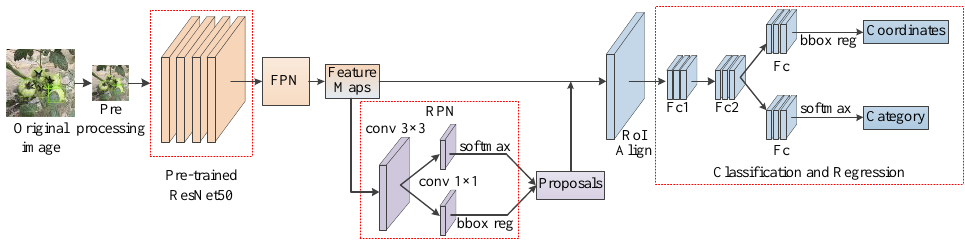
Figure 5. The overall structure of improved Faster R-CNN with Attention Mechanism.